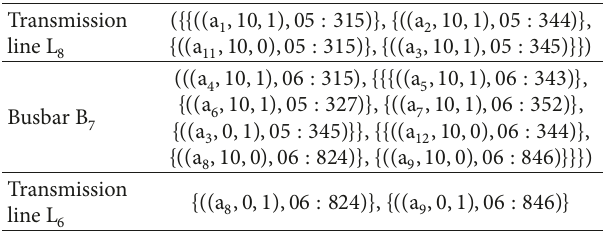
Table 10: Failure collection.